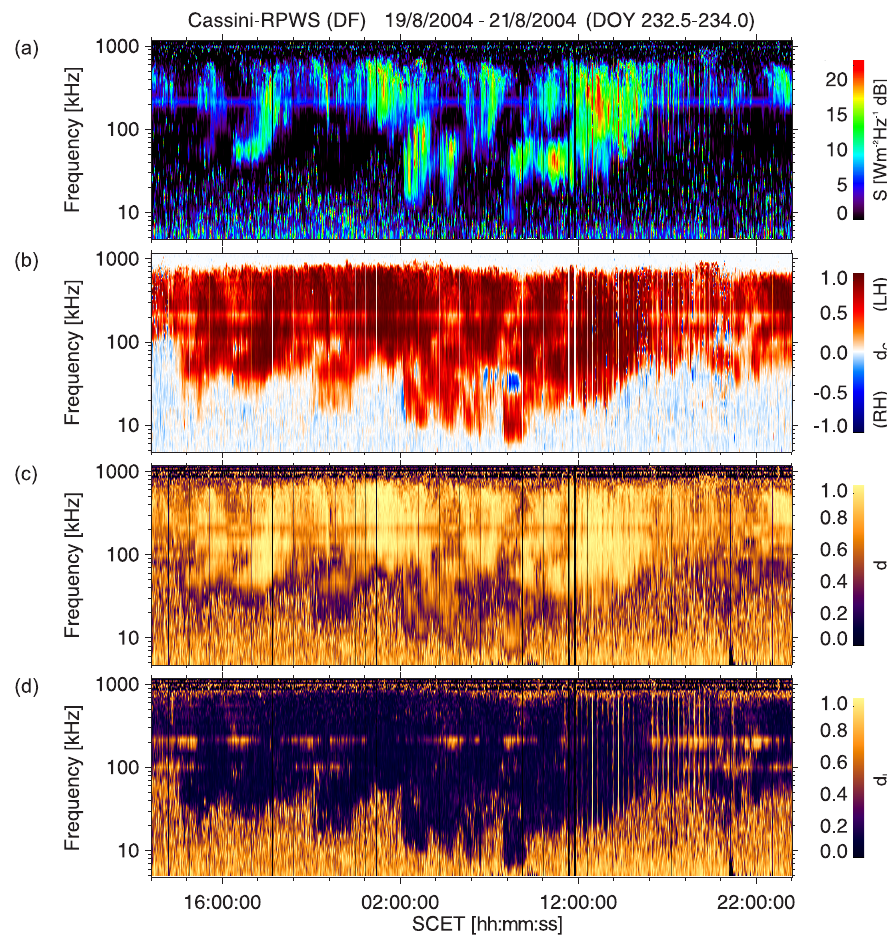
Fig. 2. Cassini-RPWS dynamic spectra for (a) the Stokes parameter S (= total intensity), (b) the degree of circular polarization d c , (c) the degree of polarization d and (d) the degree of linear polarization d L as a result of the Direction-Finding computations for the time period DOY 232.5–234.0,